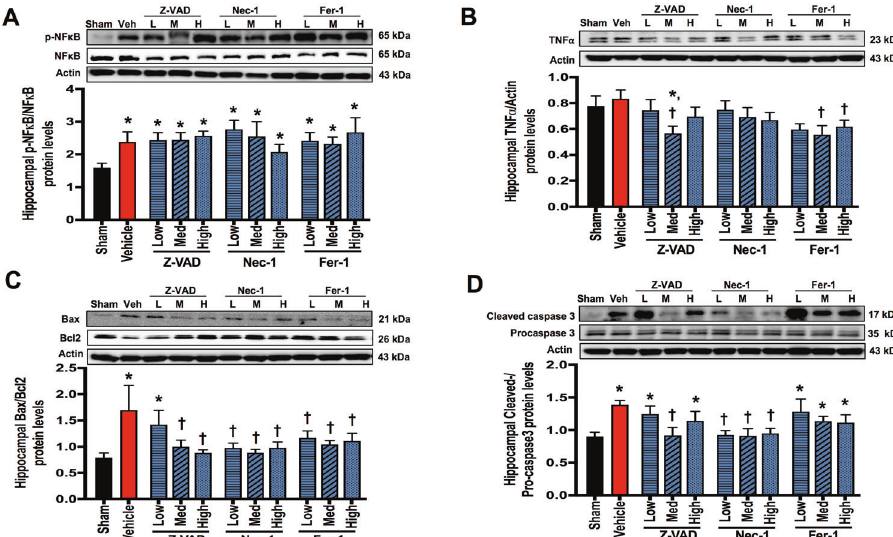
Fig. 4 The effects of cell death inhibitors on hippocampal in fl ammation and apoptosis signaling pathways. A p-NF- κ B/NF- κ B protein expression; B TNF- α protein expression; C the ratio of Bax/Bcl-2 protein expression; D cleaved caspase-3/procaspase-3 protein expression ratio. Data are shown as mean ± SEM. * P < 0.05 vs. Sham, † P < 0.05 vs. Cardiac I/R + Vehicle; n = 6/group. Veh: cardiac I/R rats treated with vehicle; L: cardiac I/R rats treated with low dose of cell death inhibitor; M: cardiac I/R rats treated with medium dose of cell death inhibitor; H: cardiac I/R rats treated with high dose of cell death inhibitor. I/R ischemia/reperfusion